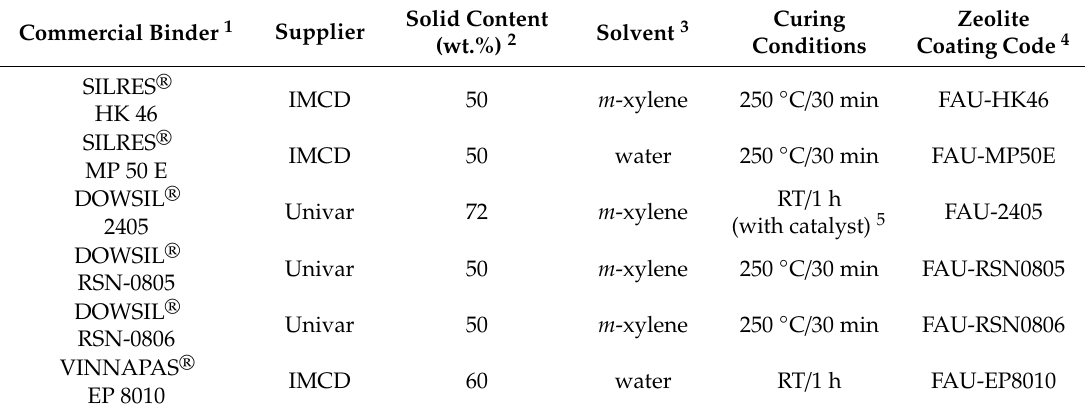
Table 6. List of commercial binders, solid content, solvent, curing conditions and zeolite coating code.